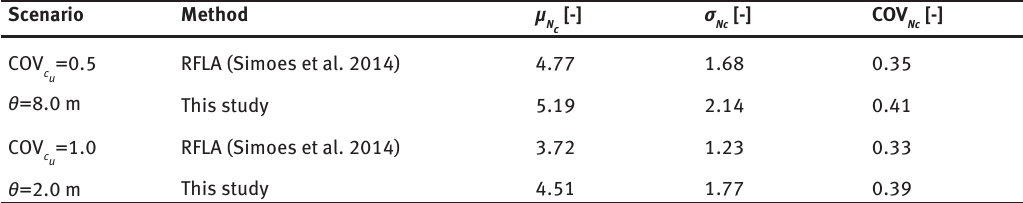
Table 1: Comparison of the results obtained in this study with those obtained by Simoes et al. (2014) by random finite limit analysis. Scenario